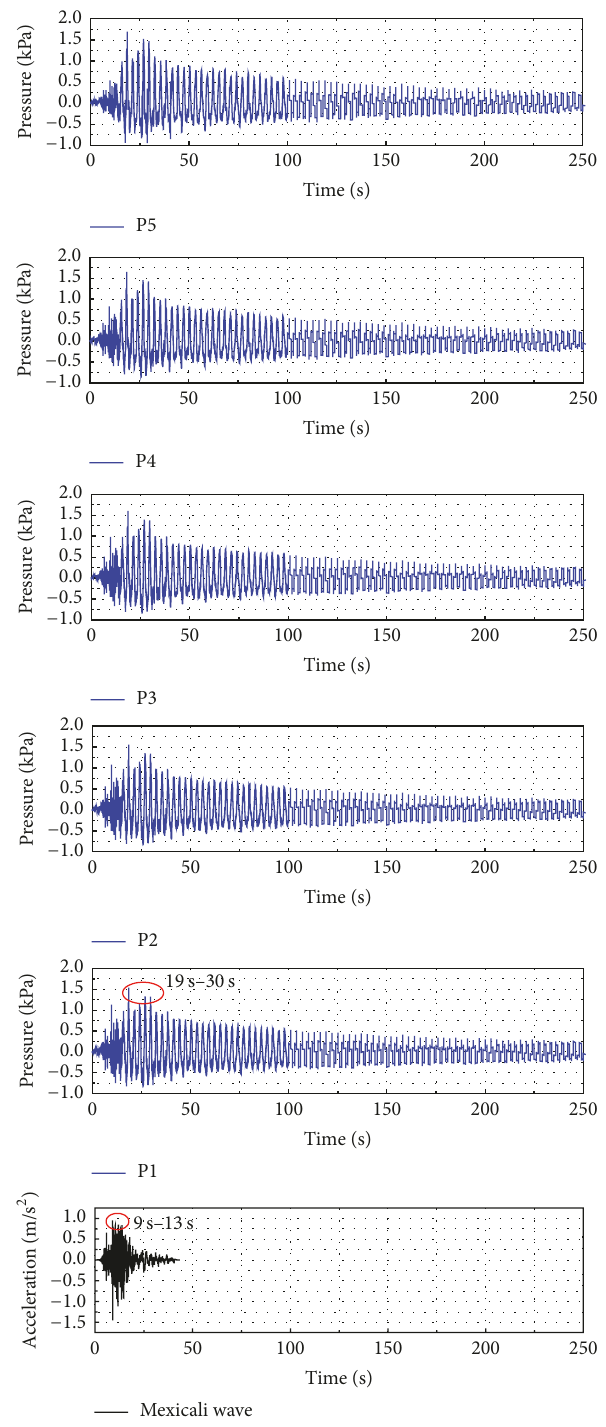
Figure 8: Fluctuations in the hydrodynamic pressures at sensors P1–P5 and the 0.15g acceleration results with respect to time due to the Mexicali earthquake waveform (EQ2).